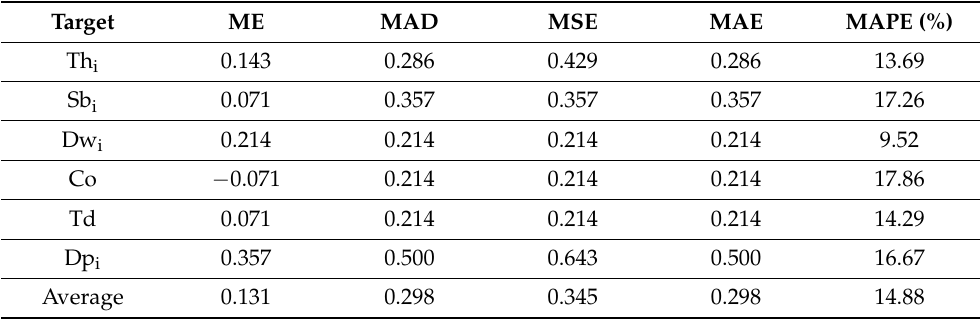
Table 9. Summary of the errors evaluated adopting the ANN on 20 cases identified by considering out-of-sample